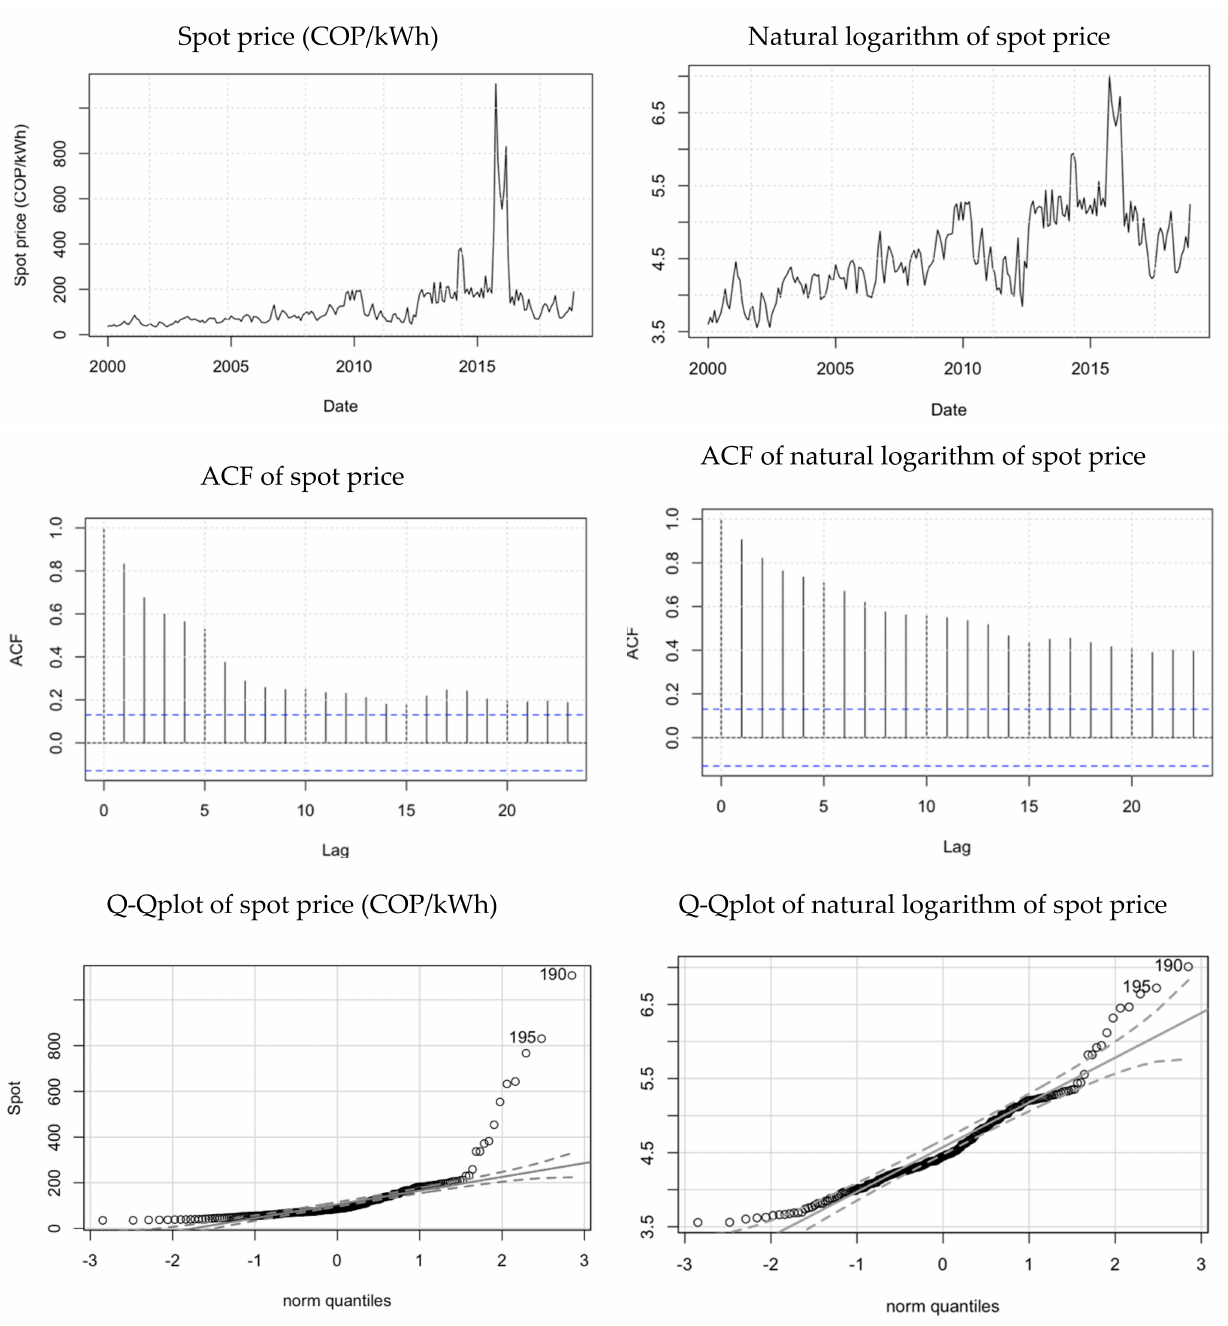
Figure 2. Spot price time series of energy in Colombia. The Q-Q plots of the spot price and of its natural logarithm are compared to the normal distribution at a 95% confidence